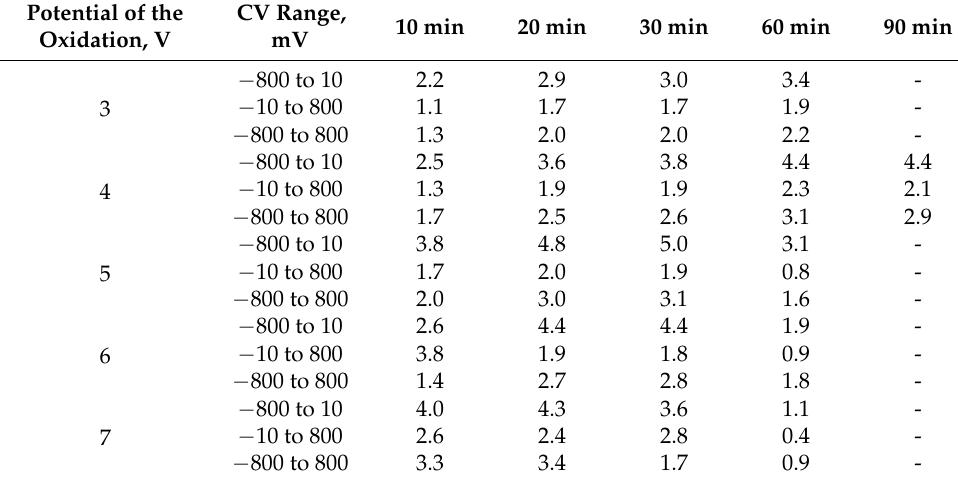
Table 1. The C ox / C 0 ratio of MWCNT/Al for various time of anodic oxidation at different potential. Electrolyte was 0.005 M aqueous Na 2 SO 4